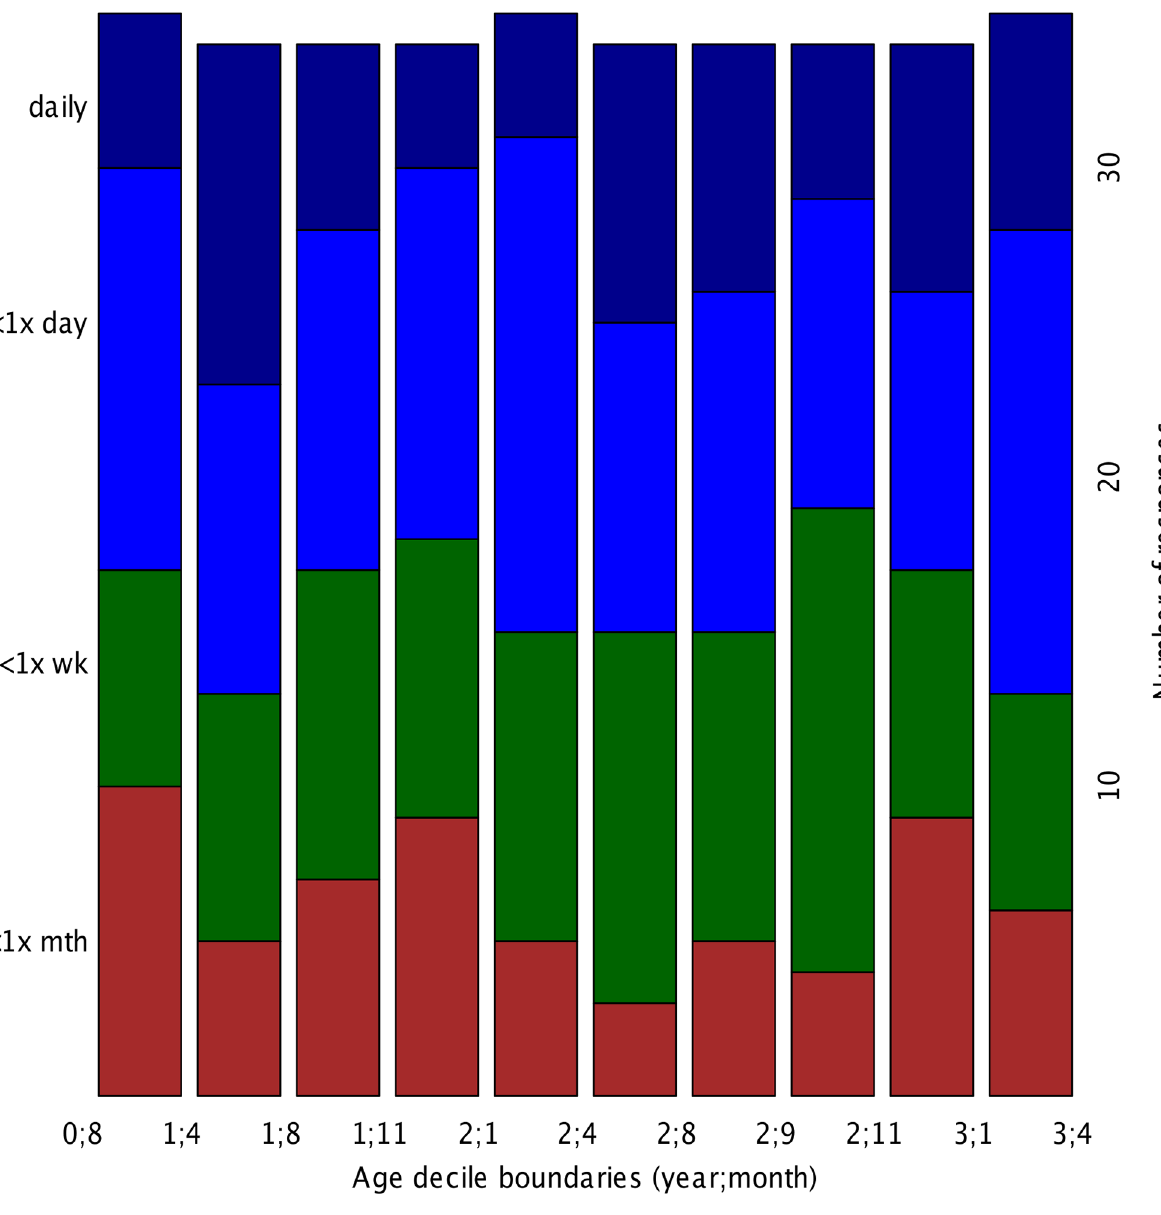
Fig 2. Frequency of use by age (in year;month) among children reported to have used touch screens in the past. Data is grouped in deciles to even the number of infants in each category. As in Fig 1, “ < 1× ” stands for “ less than once a ” ; “ wk ” stands for “ week ” and “ mth ” for “ month ” .